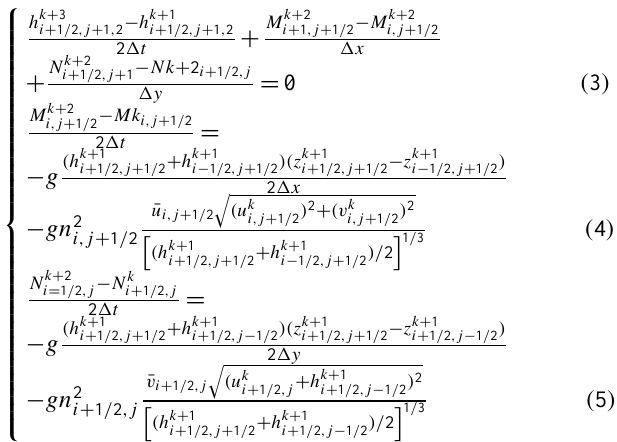
Table 1. The half-experiential data adopted.